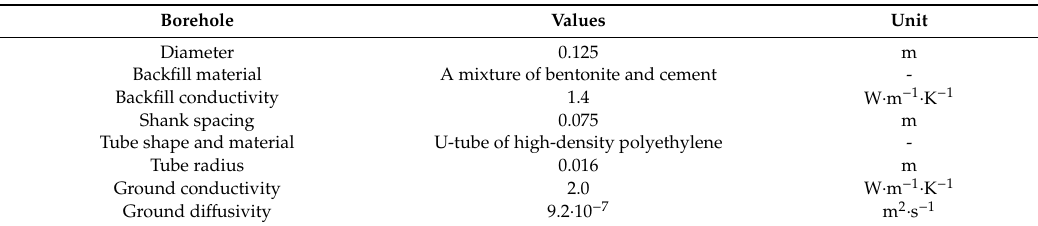
Table 3. Borehole main